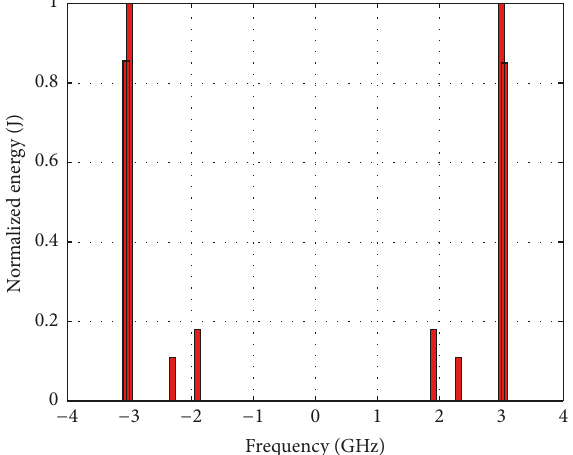
Figure 13: Pole normalized 𝐸 levels with